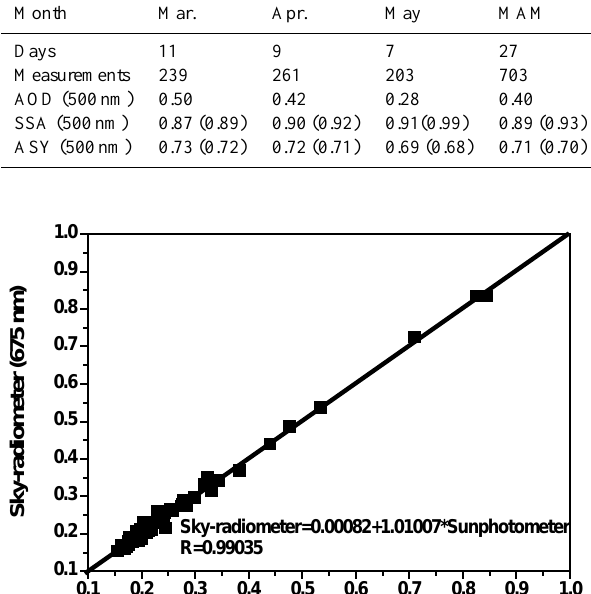
Table 2. The number of clear-sky days and measurements by sky- radiometer in spring of 2009 and the retrieved averaged AOD and adjusted SSA and ASY in MAM (unadjusted values are shown in brackets). Month Mar. Apr.